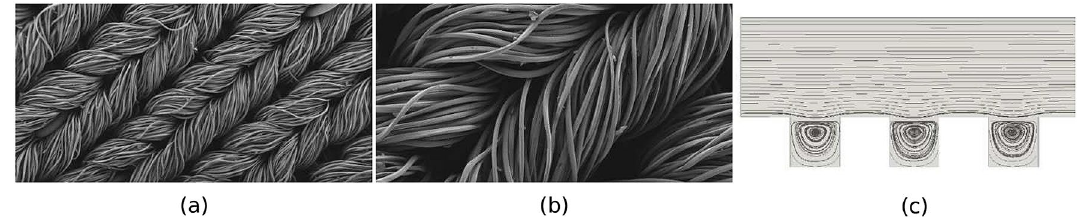
Figure 3. Uneven topography of microbicidal fabric. ( a ) SEM photograph at 118 × magnification. ( b ) SEM photograph at 363 × magnification. ( c ) Recirculating flow due to uneven topography simulated in OpenFOAM-7. ( a , b are outputs of the Field Emission Scanning Electron Microscope (MERLIN Compact VP from M/s.Carl Ziess), c created using Paraview (https:// www. kitwa re. com/ platf orms/# parav iew)).